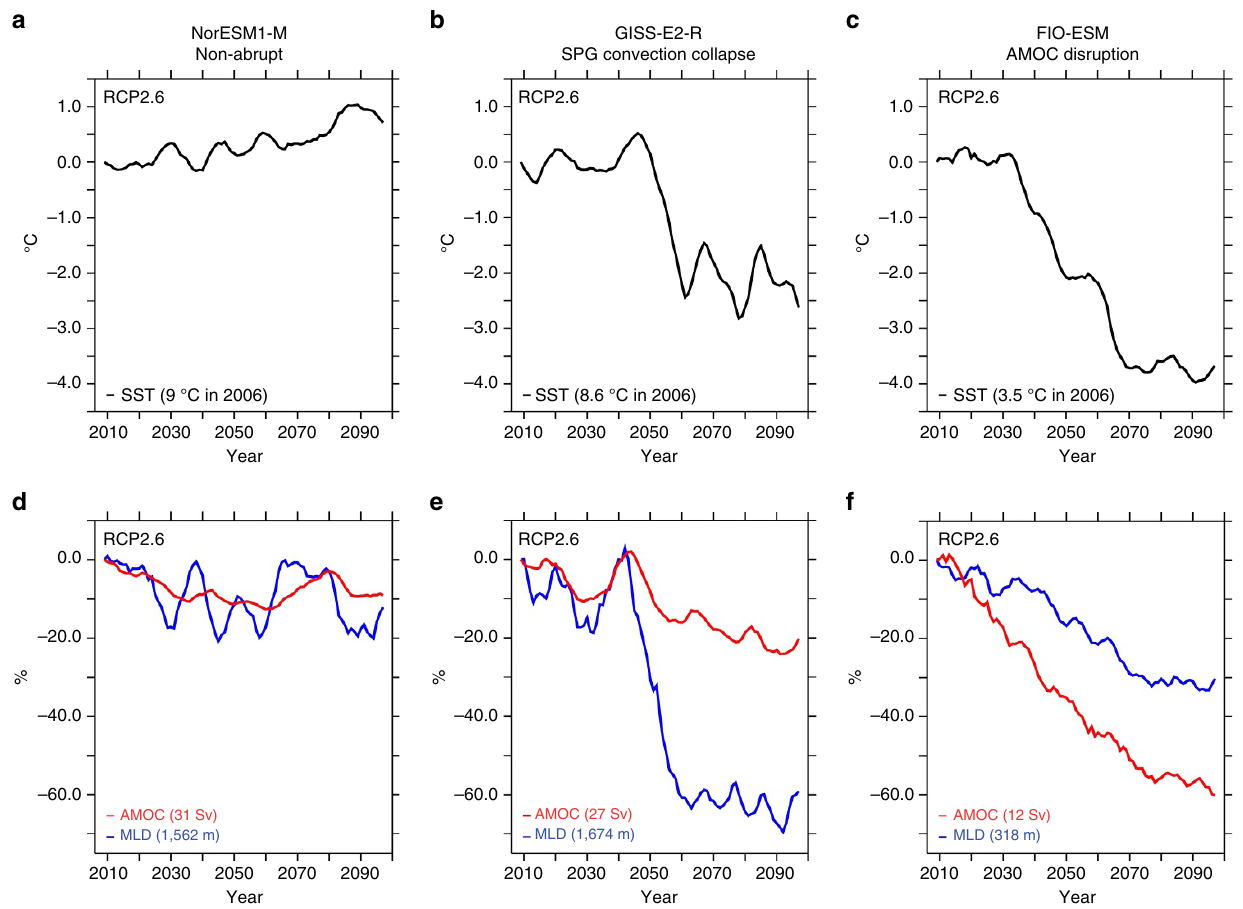
Figure 3 | Characterization of the different SSTresponses in the SPG. Examples of the SST, MLD and AMOC evolutions over the SPG in the three model subsets (non-abrupt, SPG convection collapse and AMOC disruption) for the RCP2.6 scenario. Only one example for each sub-ensemble is shown